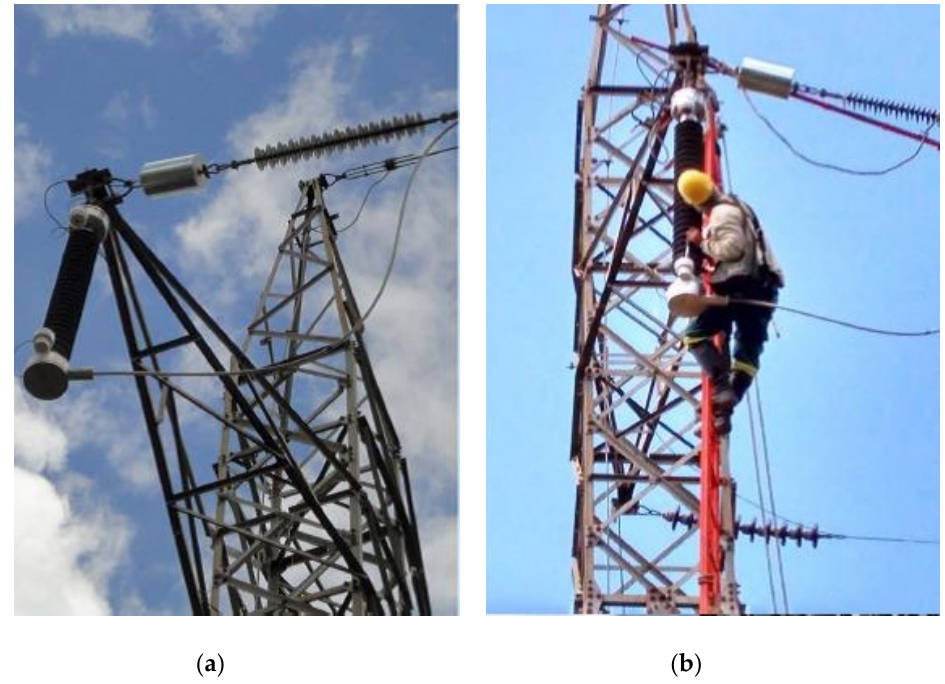
Figure 23. ( a ) Optical wireless (OW) device anchored in a tower of the transmission line, ( b ) a technician aligning the collimators on the top of the high voltage tower [77].